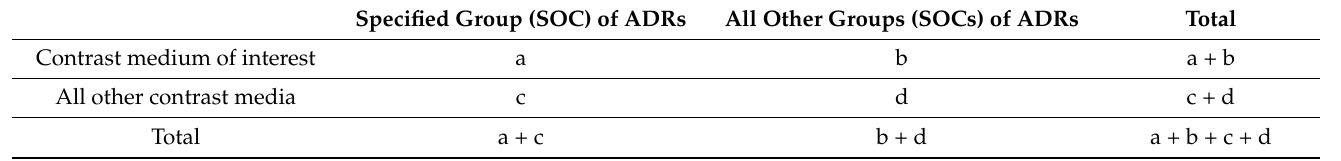
Table 2. A table for a contrast medium and group of ADR in spontaneously reported data.